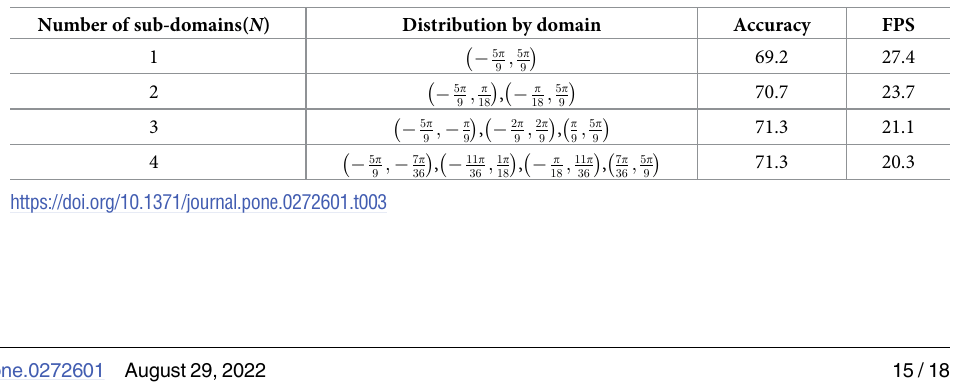
accurate sub-network is selected autonomously by an adaptive angle selector (Angle Selector), which can well cope with the situation that characters in irregular text span a wide range of rotation angles. It achieves excellent performance while eliminating the tedious manual selec- tion operation. The proposed curvature-adaptive character linking algorithm VDLink also provides a significant performance improvement over traditional character linking methods while incurring almost no computational overhead. However, the accuracy of this model strongly depends on the accurate regression of the character angle, which directly affects whether a suitable character recognition sub-network can be selected for the detection of the target character. How to design a more efficient and accurate angle regressor for characters is the next focus of this work.